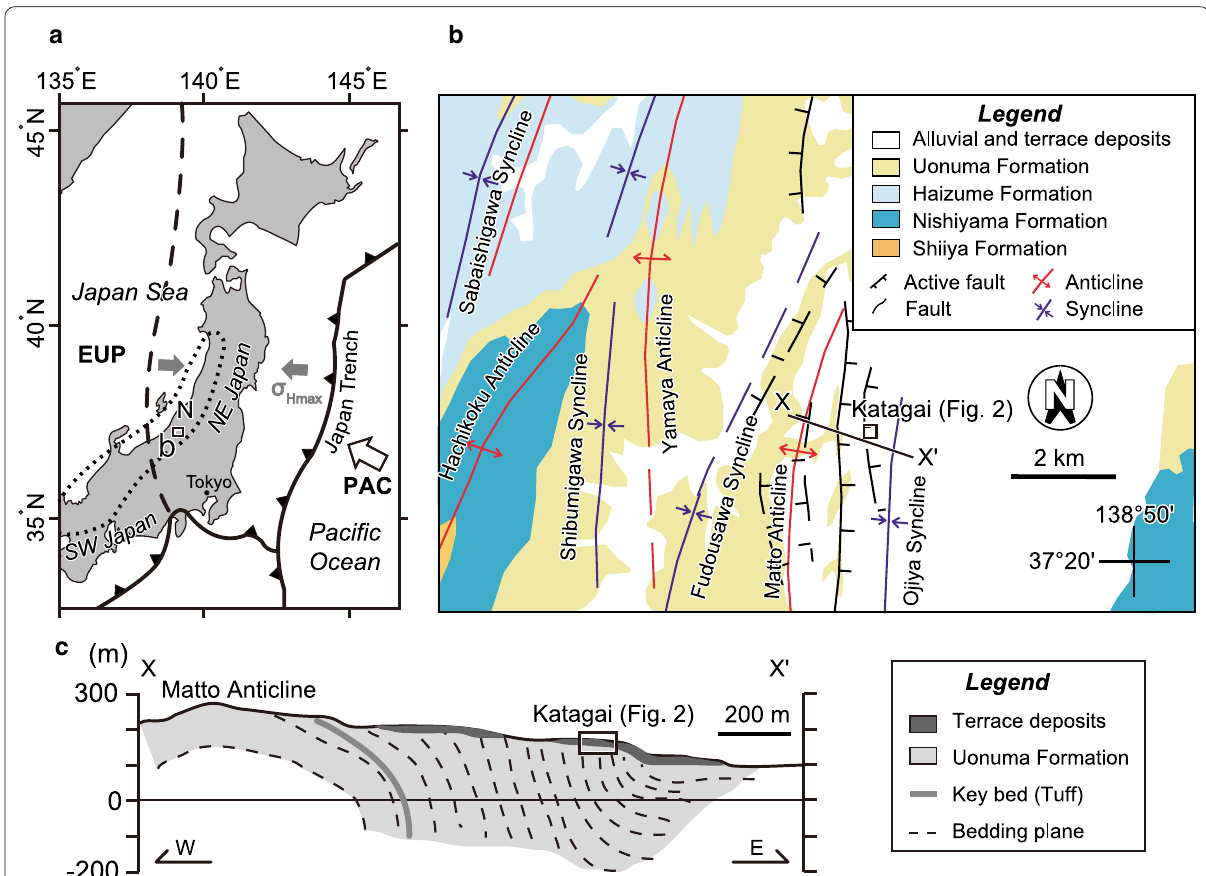
Fig. 1 a Index map of the study area. The area surrounded by the dotted line is the Niigata–Kobe Tectonic Zone (NKTZ; Sagiya et al. 2000). The study area is located in the NKTZ. N: Niigata region. PAC: Pacific Plate. EUP: Eurasian Plate. σ Hmax is the maximum horizontal stress (Terakawa and Matsu’ura 2010). b Geological map of the mid-Niigata region, Central Japan (Niigata Prefectural Government 2000). c Geological cross-section along the line X–X’ in b . The Katagai site is located in the eastern limb of the Matto